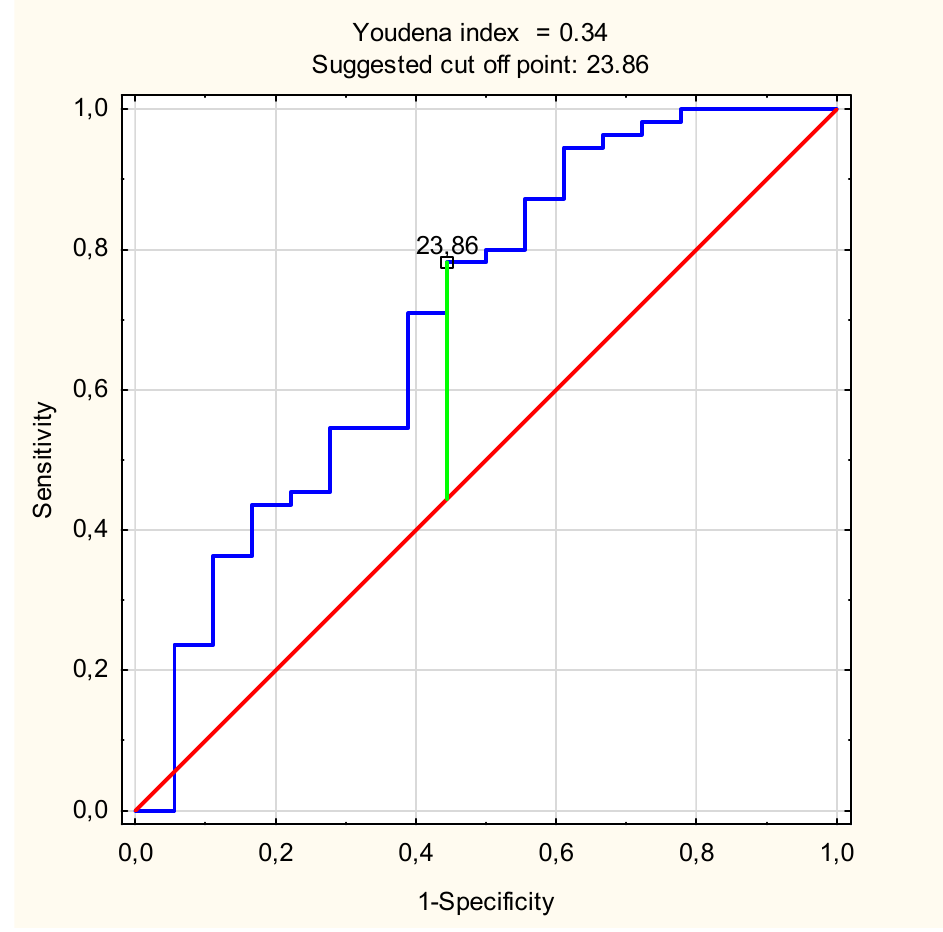
Figure 2. ROC curve for C18:1-Cer measured in the 1st trimester of pregnancy (AUC = 0.702 (95% confidence interval: 0.552–0.852; p = 0.008) with optimal cut-off value of 23.87 ng/mL).